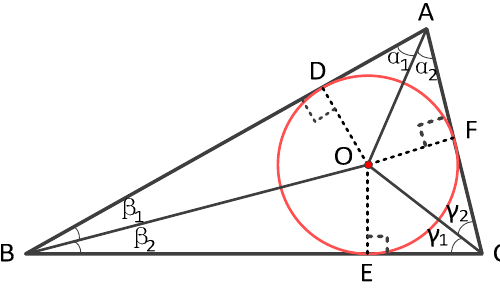
Figure 8. Diagram of triangle’s center.